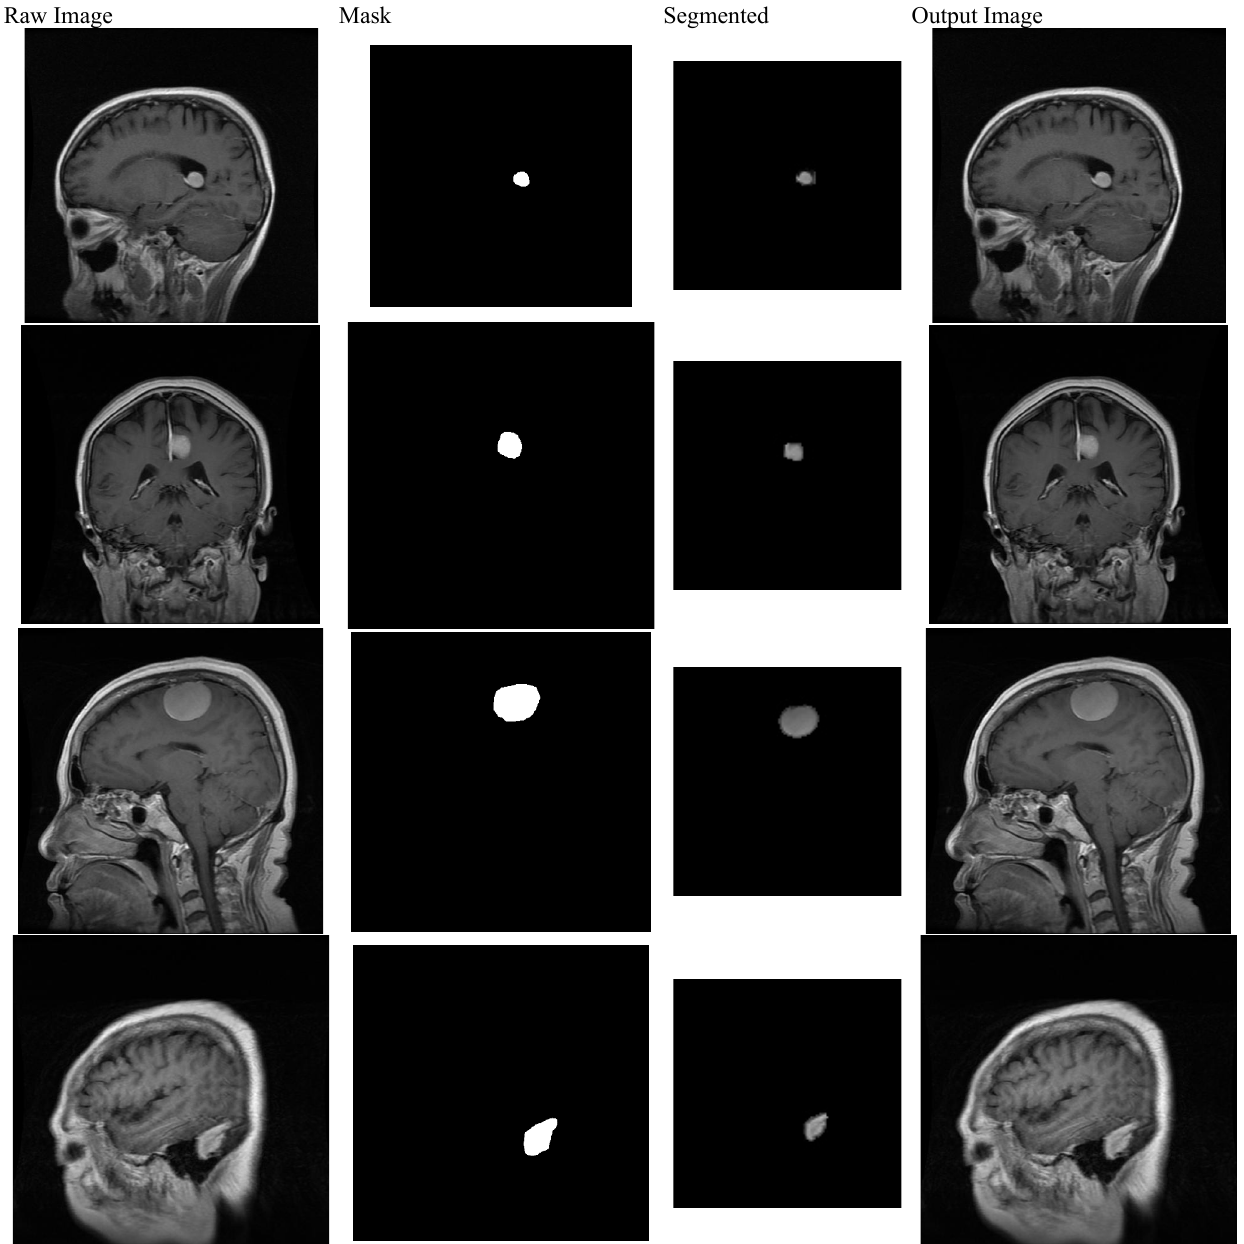
Figure 13. Various stages of the pre-processing (masking), segmentation, and output image of brain analysis.